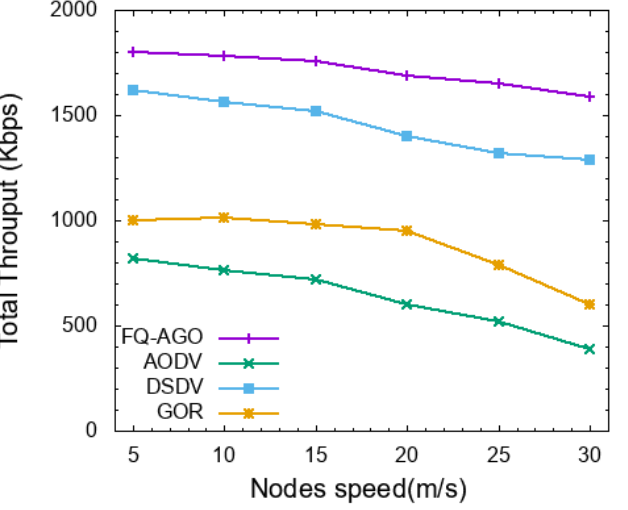
Figure 8. Throughput vs. nodes speed.